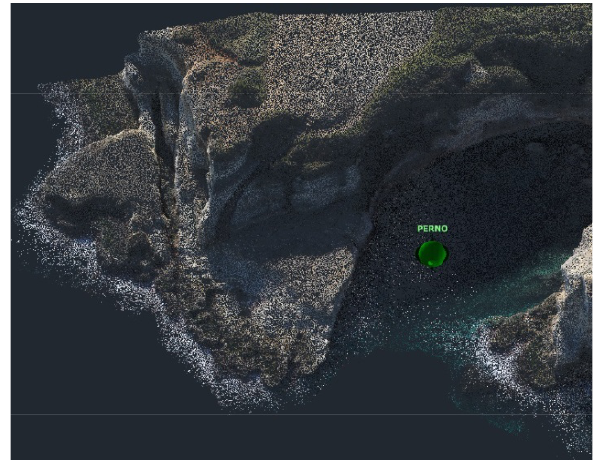
Figure 11: GIS layers with open fractures